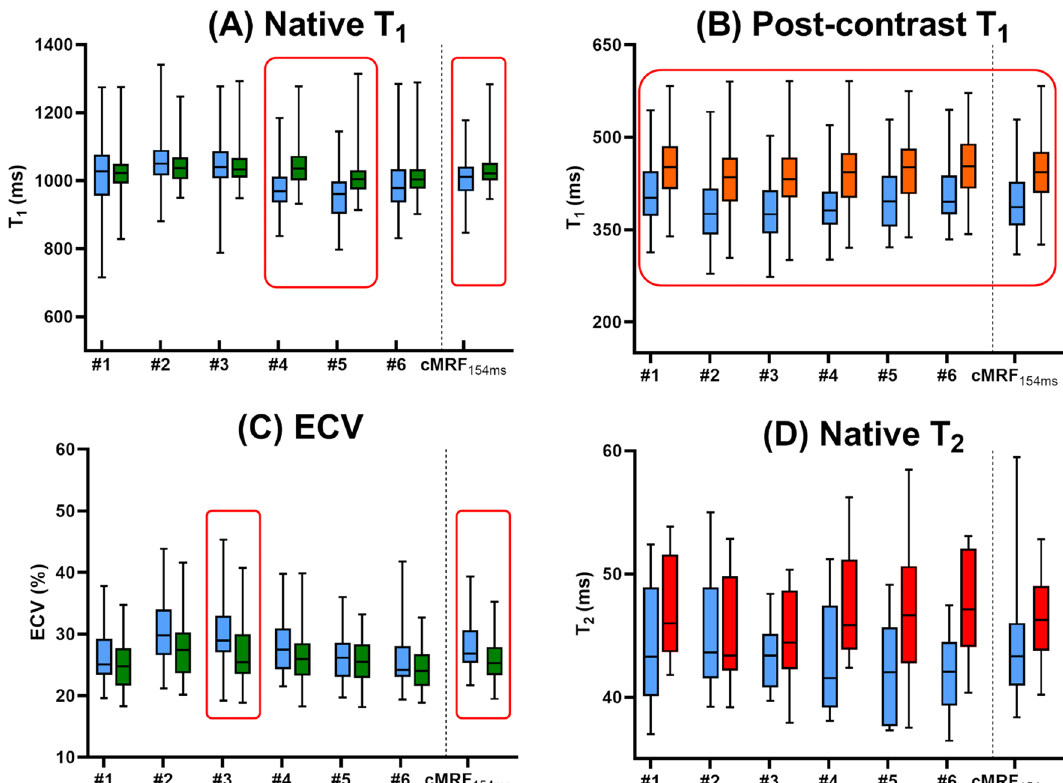
Figure 5. Box and whiskers plots of segmental relaxation times in the myocardium of the patient group. Boxes are medians with interquartile ranges; whiskers indicate the minimum and maximum values. The segments that showed a statistically significant difference (P < 0.05) are outlined in red. ( A – C ) Native T 1 , post-contrast T 1 and synthetic ECV measured with short-acquisition-window cMRF (left, blue) and MOLLI (right segment, orange and green). cMRF and routine techniques have similar ranges. ( D ) Native T 2 measured with cMRF (left, blue) and T 2 prep bSSFP (right, red). The numbers indicate the AHA segment number and ‘avg’ is the average across the entire